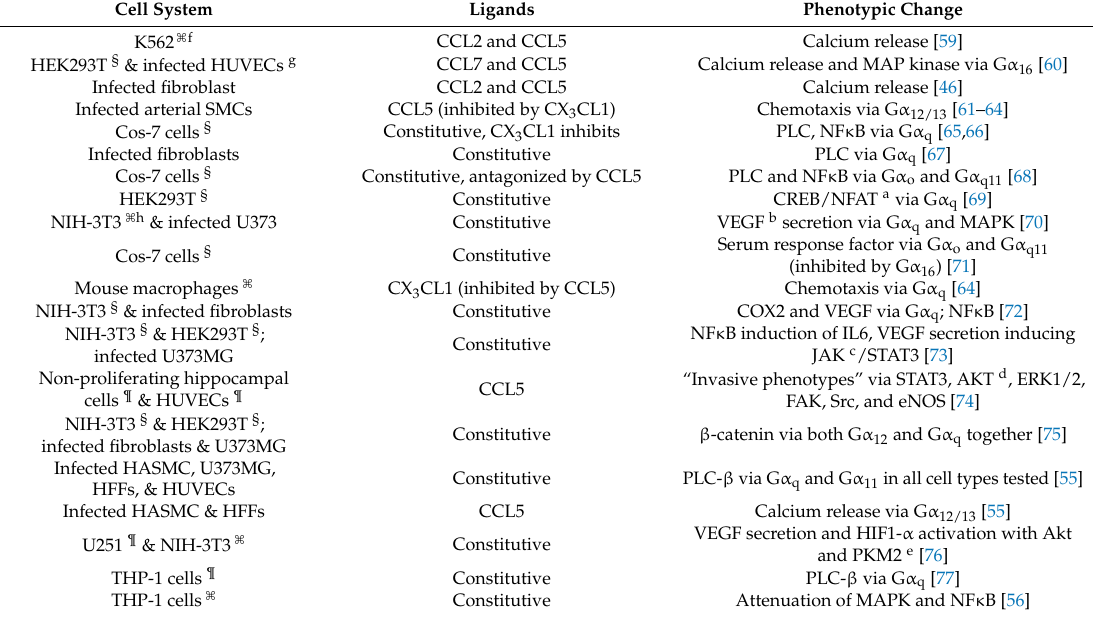
Figure 2. Summary of pUS28 ‐ mediated signaling during HCMV infection. pUS28 ‐ mediated signaling during infection of the indicated cells. An additional summary of signaling pathways that are modulated in response to pUS28 overexpression is found in Table 2. The pUS28 structure in the center is based on the pUS28 crystal structure, bound to CX 3 CL1 ([34]; PDB ID: 4XT3), using Chimera [35] and the Orientations of Proteins in Membranes (OPM) databases [36]. Table 2. Summary of pUS28 ‐ mediated signaling properties. The effects of pUS28 signaling in the presence or absence of a ligand (middle column) are detailed (right column). The cell type used is shown (left column) and the expression system for experiments providing pUS28 in trans are noted. Experiments that detailed the effects of signaling in response to pUS28 overexpression and in the context of infection are denoted by symbols. Constitutive, CX 3 CL1 inhibits PLC via G α q [67] Non ‐ proliferating hippocampal cells ¶ & HUVECs ¶ NIH ‐ 3T3 § & HEK293T § ; infected fibroblasts & U373MG Infected HASMC, U373MG, HFFs, & HUVECs